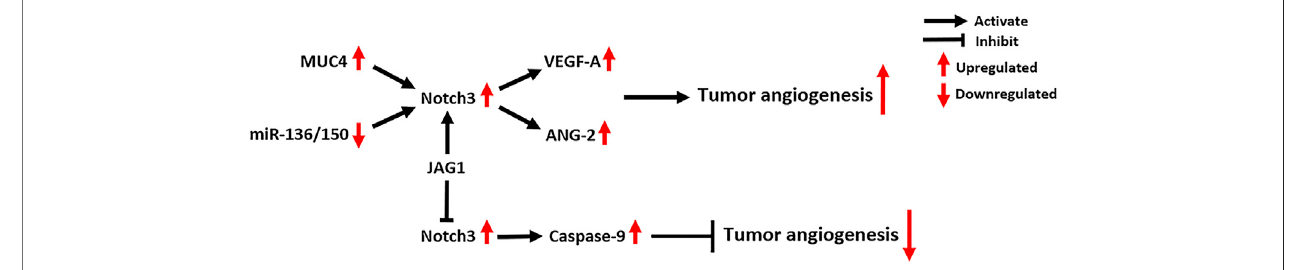
FIGURE7| Notch3-relatedmolecularmechanisms intumor angiogenesis. MUC4: Mucin4, CellSurfaceAssociated; VEGF-A:Vascular EndothelialGrowthFactor A; ANG-2: Angiogenin